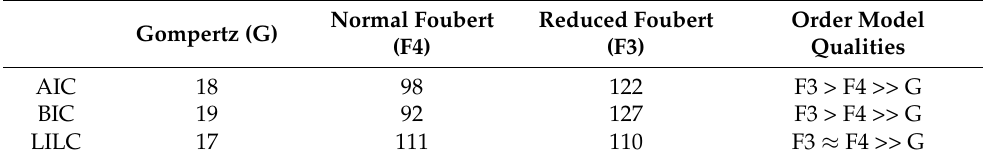
Figure 1. Typical profile of hydroperoxides (LOOHs) ( A ) and aldehyde ( B ) generation over time under accelerated shelf-life conditions (50 ◦ C) measured by proton Nuclear Magnetic Resonance ( 1 H NMR). Three different formulations are displayed: no ethylenediaminetetraacetic acid (EDTA) (black), EDTA-alternative (grey), EDTA (white). In A, a line is drawn at 38 mmol/kg, the estimated critical concentration of LOOHs (CC LOOH ), after which the secondary acceleration is engaged. Lines are solely drawn with the purpose of guiding the eye (no fit). Table 1. Comparison of information criteria Aikake Information Criterion (AIC), Bayesian Informa- tion Criterion (BIC), and Law of Iterated Logarithm Criterion (LILC) for the models G, F3, and F4. The displayed numbers represent the number of curves (within the 238 curves tested) that presented the lowest criterion-value for each